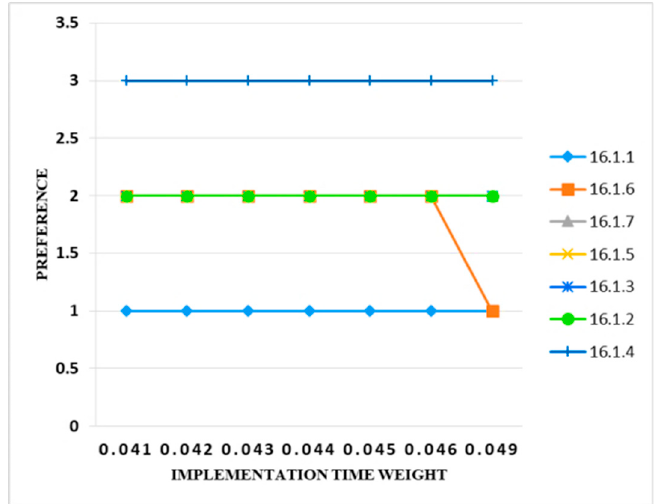
Figure 10. Sensitivity analysis of preference and implementation time weight.